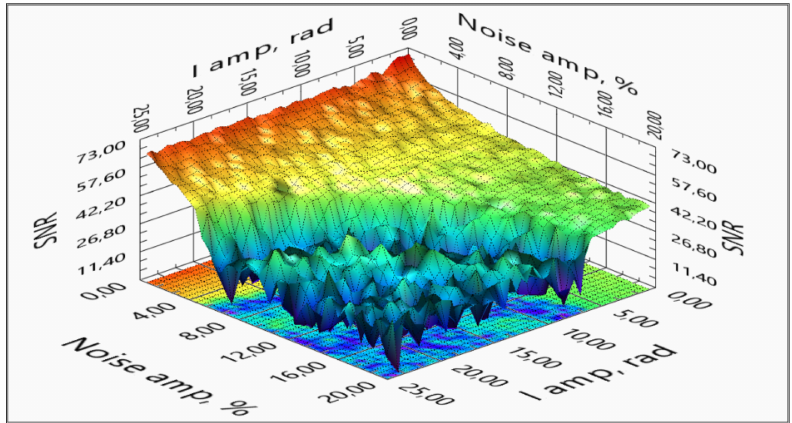
Figure 22. Measured signal SNR vs. signal amplitude vs. source signal noise.